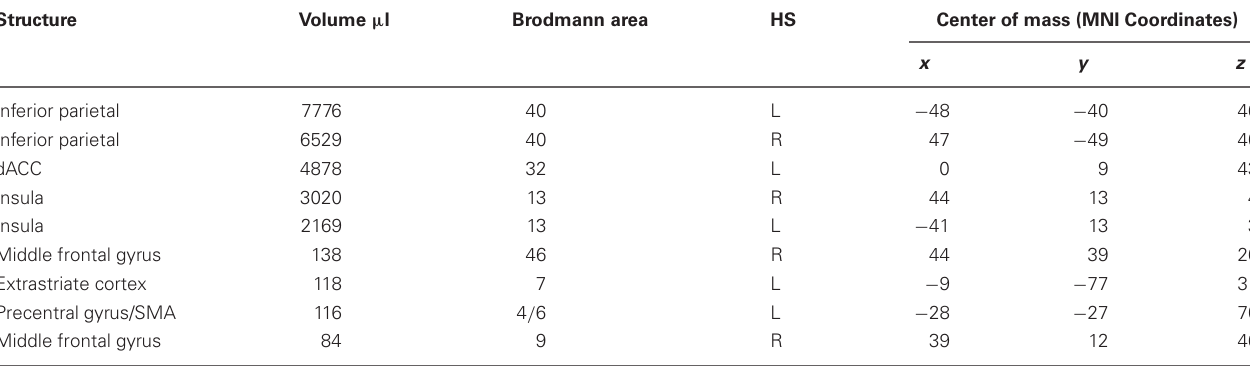
Table A1 | Regions that showed significantly greater BOLD signal change for aware errors than for correct go-trial responses. Structure